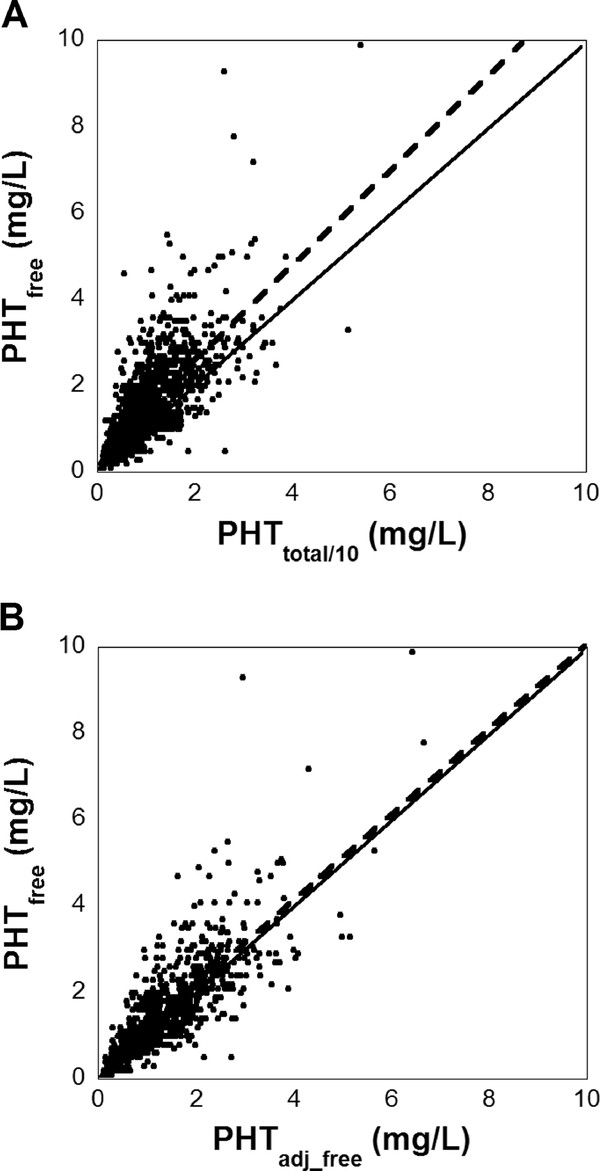
Correlation of total, adjusted, and free phenytoin plasma concentrations. (A) Correlation of PHTfree versus PHTtotal/10 for 756 patients is shown. For patients who had multiple phenytoin measurements, only the chronologically first set of PHTfree and PHTtotal/10 measurements is plotted. The solid line is the line of identity, and the dashed line is from linear regression: PHTfree = 0.385 + 1.104 * PHTtotal/10 (R2 = 0.51). The 95% confidence intervals of the intercept is (0.355, 0.415) and for the slope is (1.045,1.163). (B) Correlation of PHTfree versus PHTadj_free is shown using same source of patient data as in (A). The dashed line is from linear regression: PHTfree = 0.223 + 0.980 * PHTadj_free (R2 = 0.62). The 95% confidence intervals of the intercept is (0.129, 0.317) and for the slope is (0.926, 1.034)